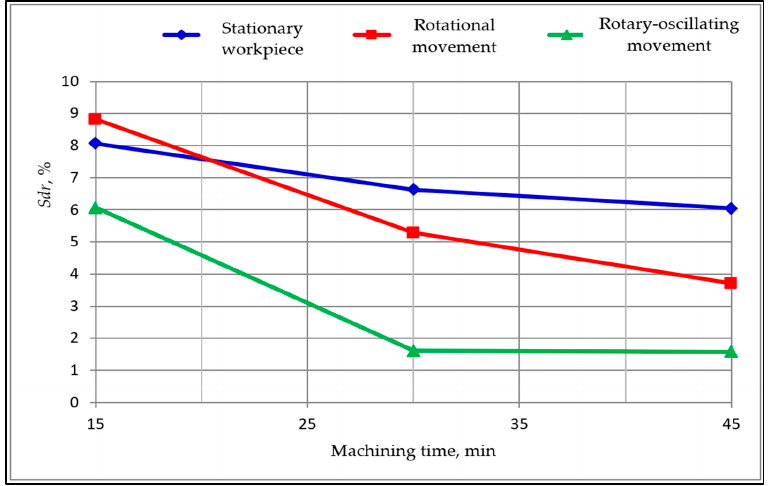
Figure 6. Changes of the developed interfacial area ratio Sdr as a function of machining time.